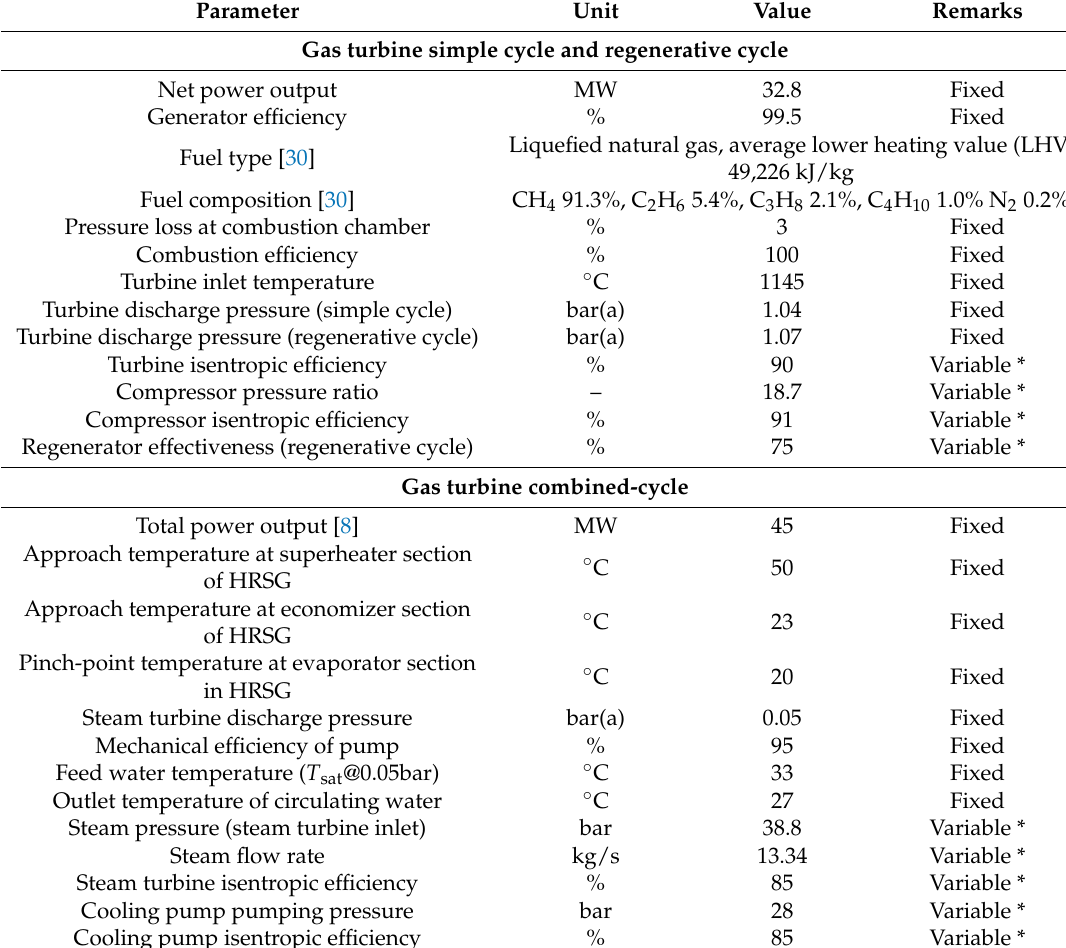
Table 3. Detailed technical data for simple, regenerative, and combined gas turbine cycles